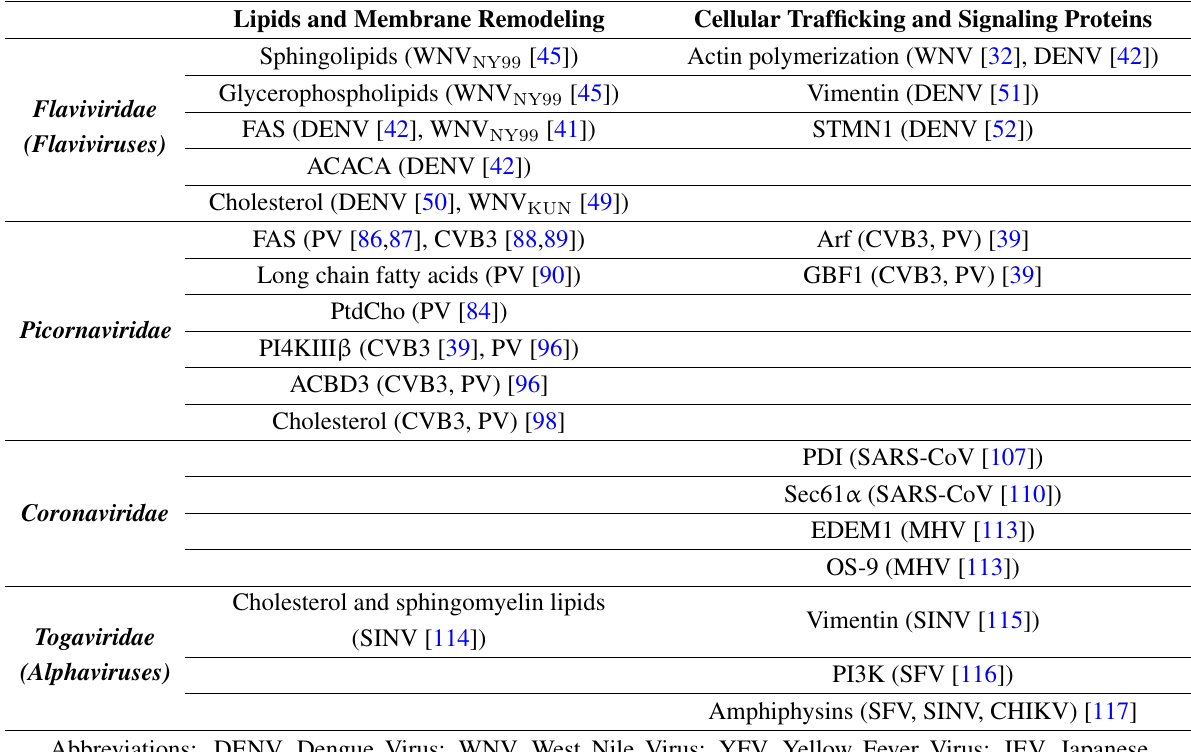
Table 1. Identified cellular interacting proteins with viral replication complexes of +RNA viruses. Lipids and Membrane Remodeling Cellular Trafficking and Signaling